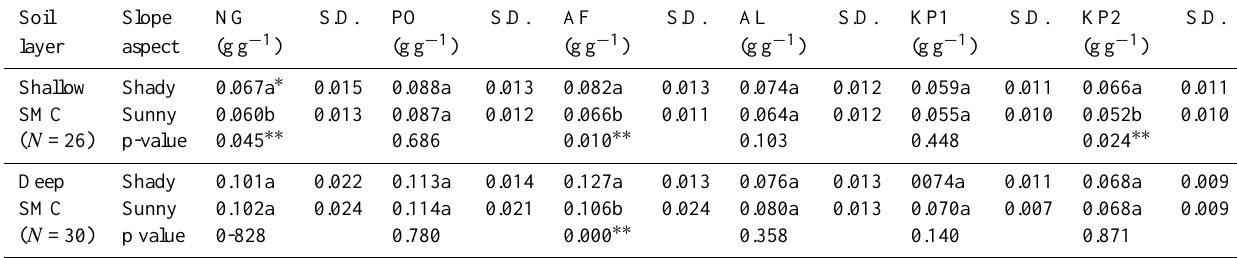
Table 3. Temporal- and depth-averaged shallow SMC and depth-averaged deep SMC on different slope aspects, together with t-test. Soil Slope NG layer aspect Shallow